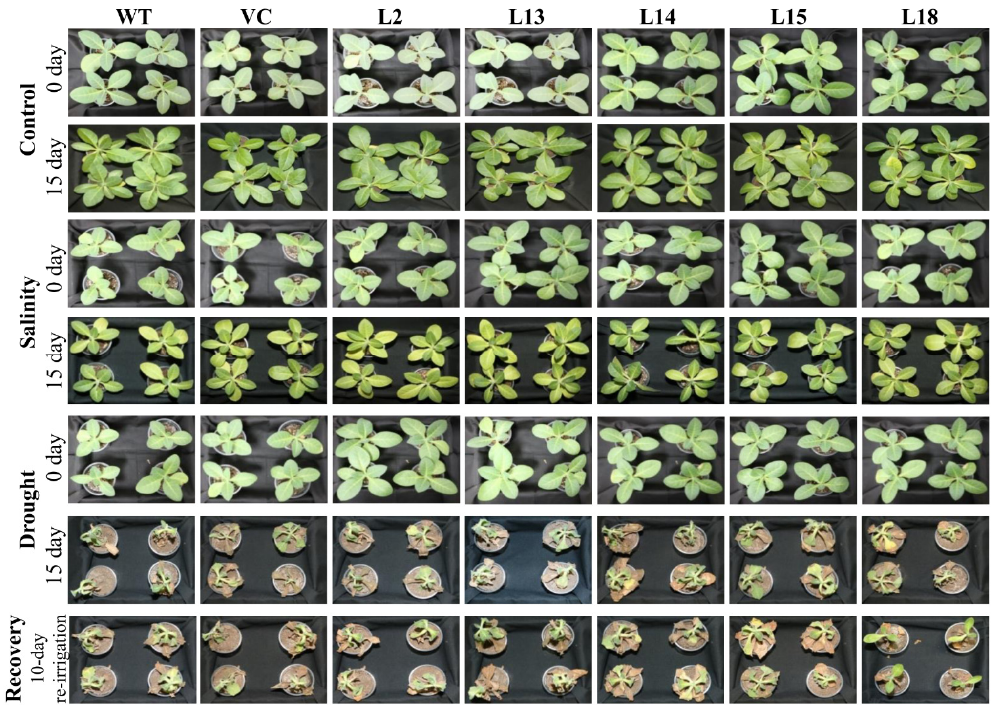
Figure 6. A comparative plant growth analysis. Morphological analysis of transgenic lines (L2, L13, L14, L15, and L18) and control plants (WT and CV) grown under different (control, salinity, and drought) conditions.